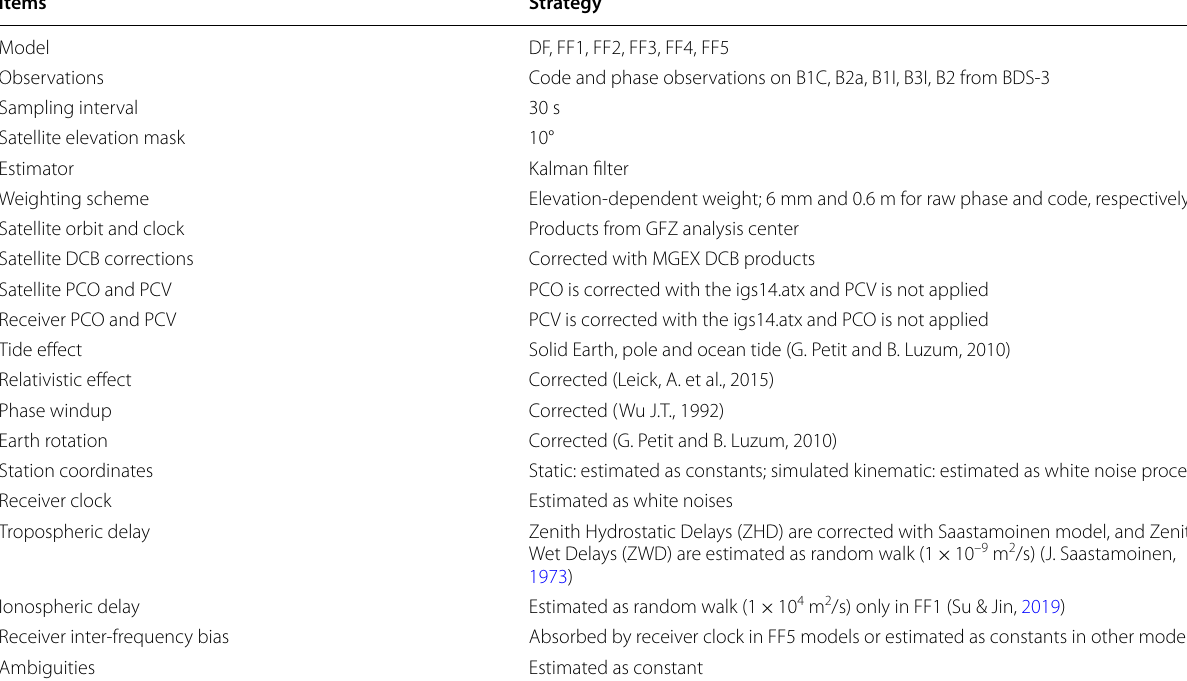
Table 3 Data processing